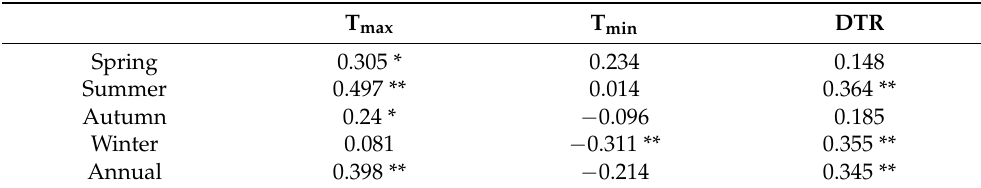
Table 4. Correlation coefficient between the trend of SD and the trends of T max , T min , and DTR at annual and seasonal scales in northeast China during